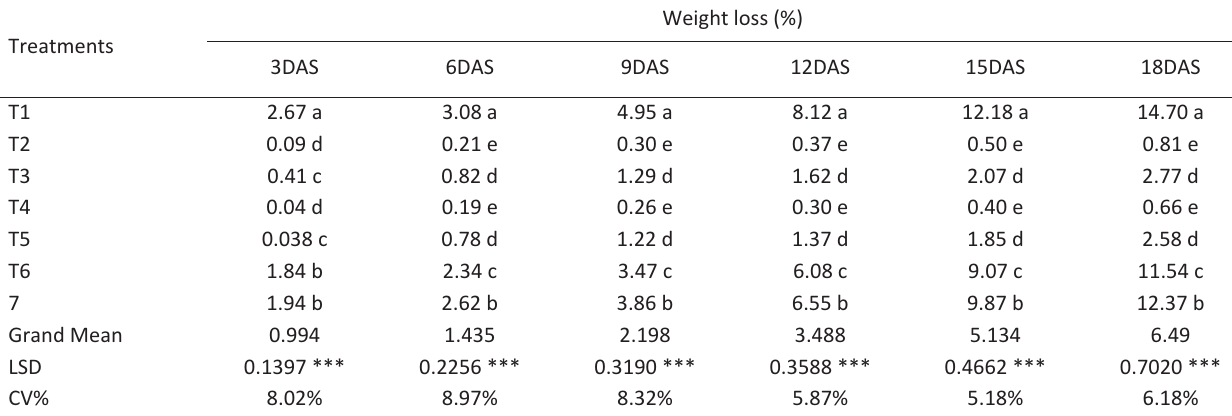
Means in the column followed by similar letters are not statistically different at p=0.05 by LSD. DAS= Days after Storage, LSD = Least significant difference, CV = Coefficient of variance, * significant at 5%, ** significant at 1%, *** sig­ nificant at 0.1% level of significance.